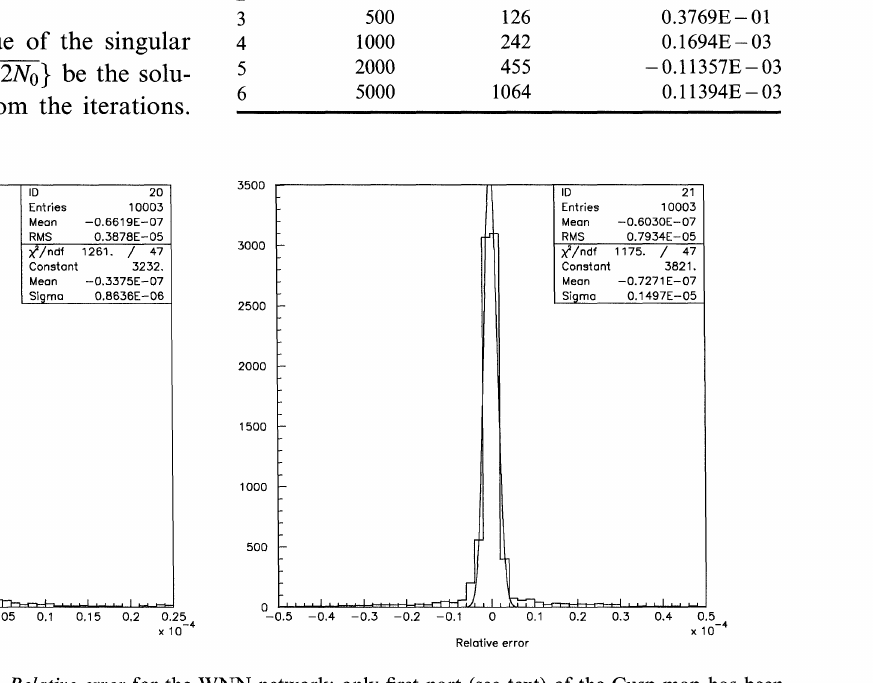
FIGURE 8 Distributions of Error and Relative error for the WNN network: only first part (see text) of the Cusp map has been